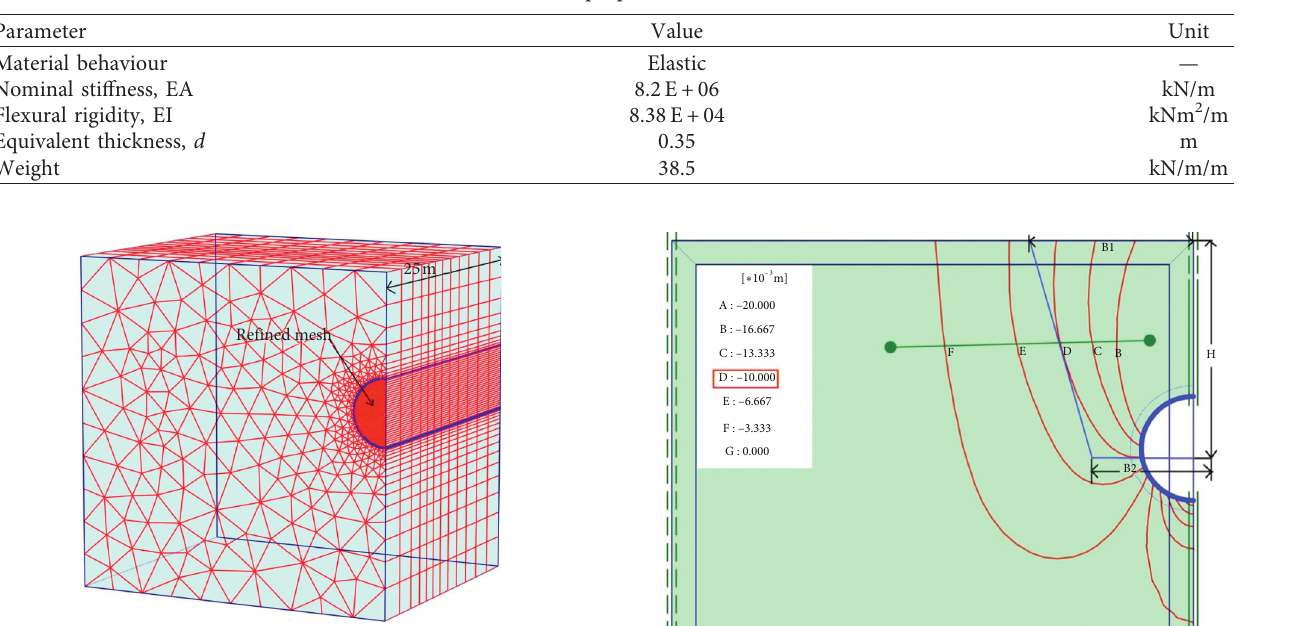
Table 2: Material properties of TBM [29].